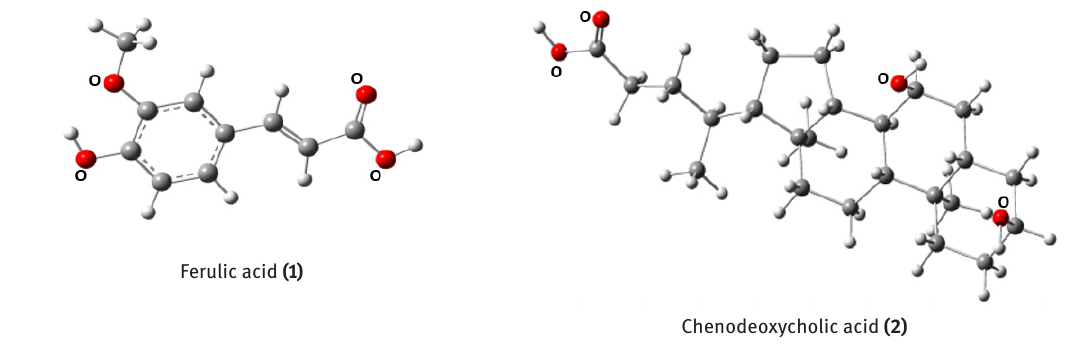
Figure 2: Molecular models of Ferulic acid (1) and Chenodeoxycholic acid (2) . Ethical approval: The conducted research is not related to either human or animal use.